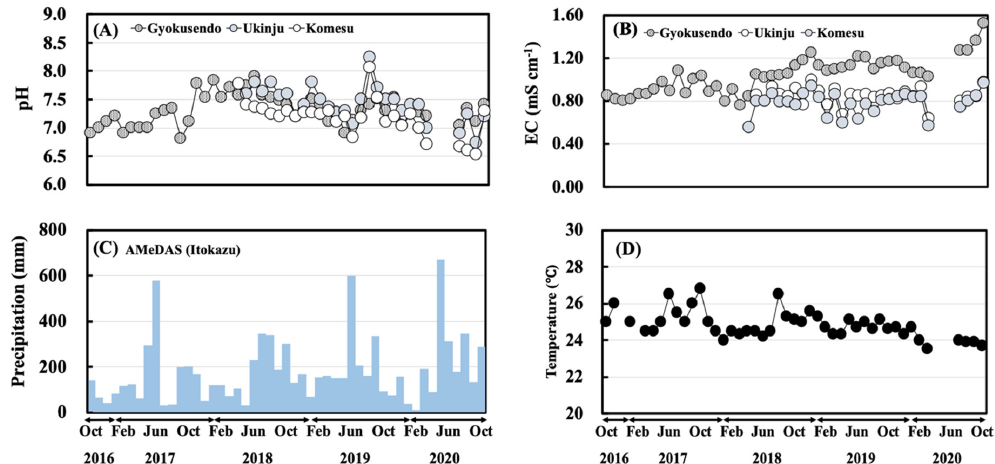
Figure 3. Monthly variations for the October 2016–October 2020 period of pH ( A ), electrical conductivity ( B ), and precipitation ( C ) in the water samples, and temperature ( D ) in the Gyokusendo cave.